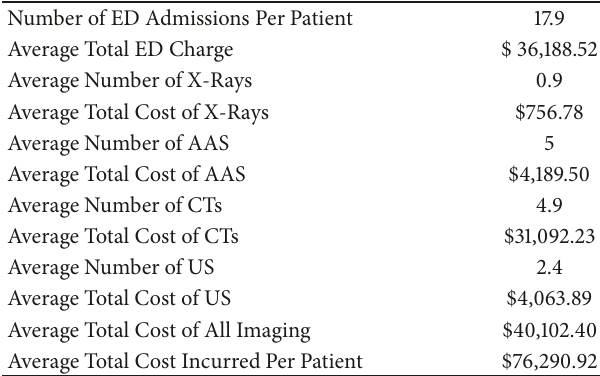
Table 1: Costs of delayed diagnosis of CH in ED hospital visits (ED: emergencydepartment;AAS:acuteabdominalseries;CT:computed tomography; US: